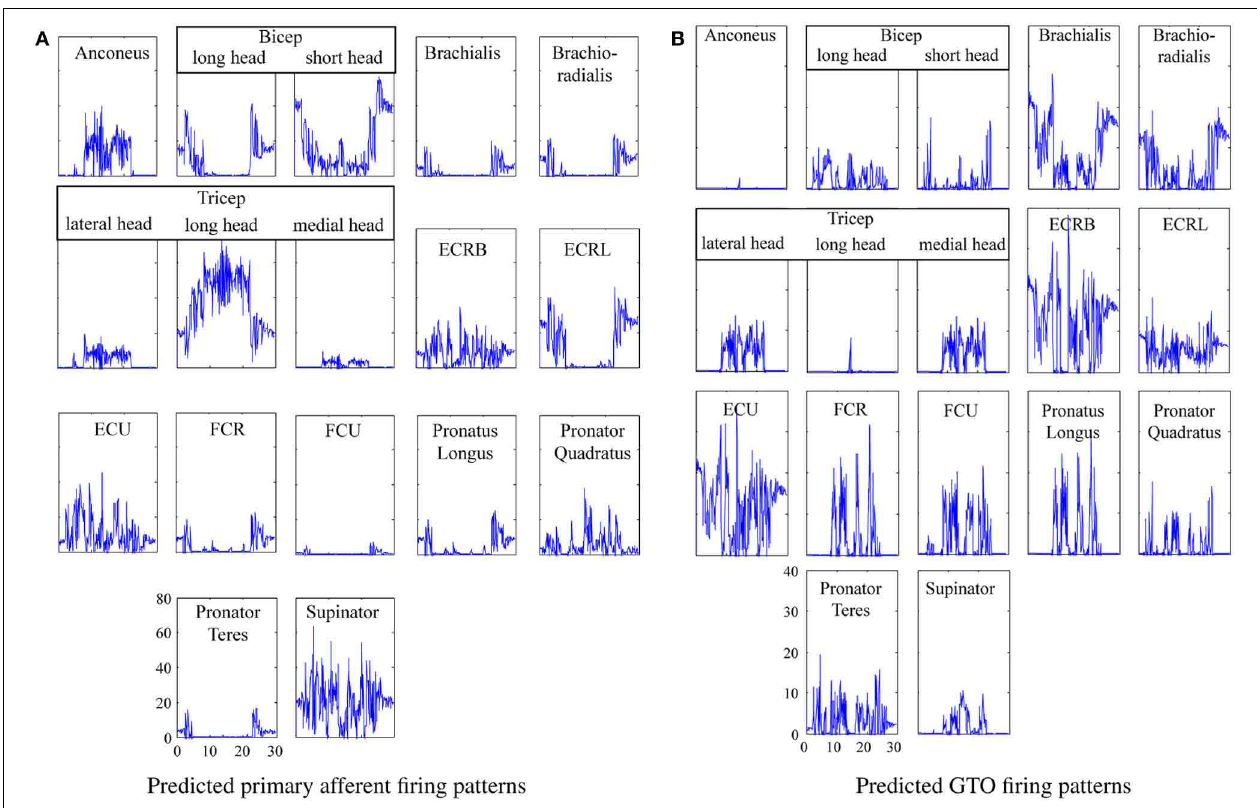
FIGURE 9 | Predicted proprioceptor firing patterns for the actor brushing his teeth. (A) Predicted primary afferent firing patterns. (B) Predicted GTO firing